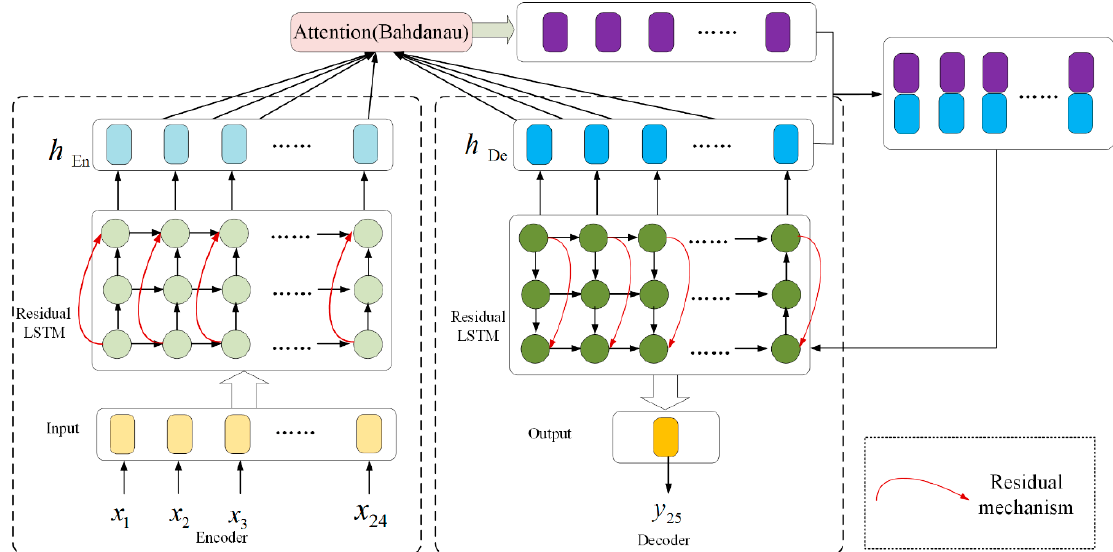
Figure 12. The short-term load forecasting model of Seq2seq.